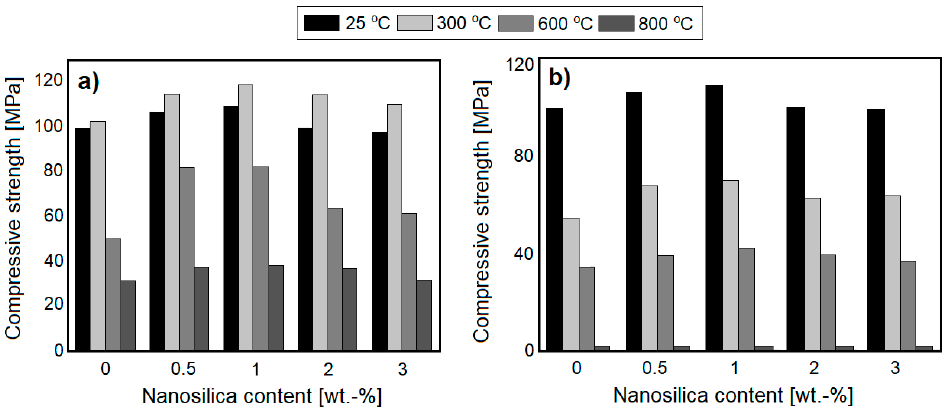
Figure 4. Compressive strength of cement pastes containing NS, after heating and cooling: ( a ) gradually in air, ( b ) suddenly in water. Reproduced with permission from [41]. Copyright Springer Nature, 2018.